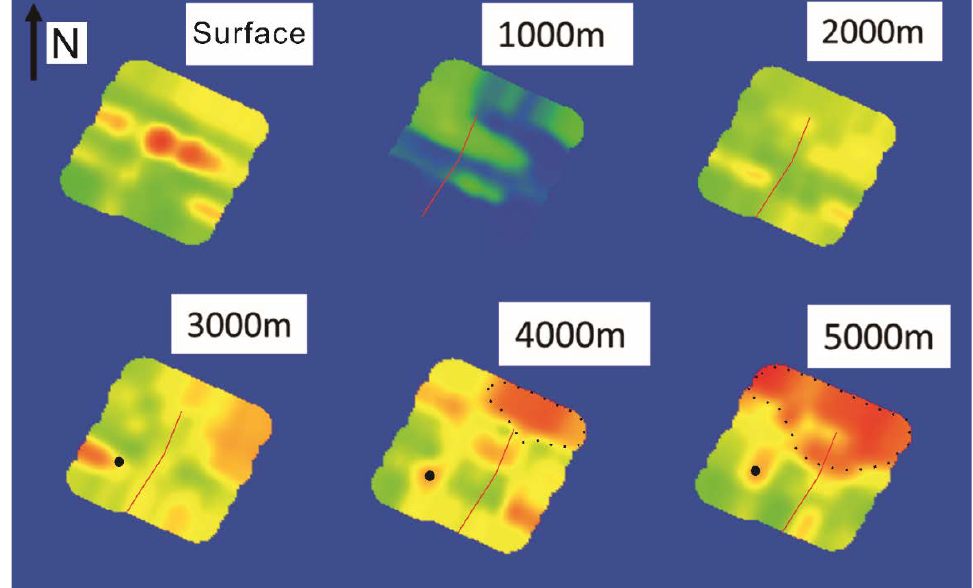
Figure 9. Resistivity map at different depths: the black dot represents the well GR1, the red line represents the fault F1, and the area dotted with black lines represents the inferred favorable area of HDR.